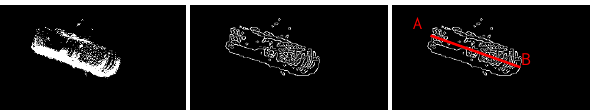
Figure 9. The vehicle model and its orientation.